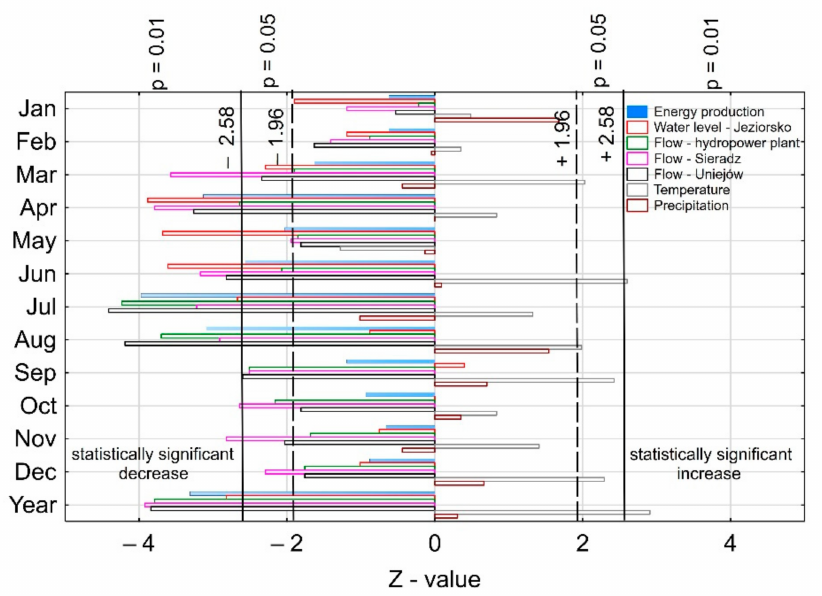
Figure 12. Directions of changes in energy production in the Jeziorsko hydropower plant and climatic and hydrological